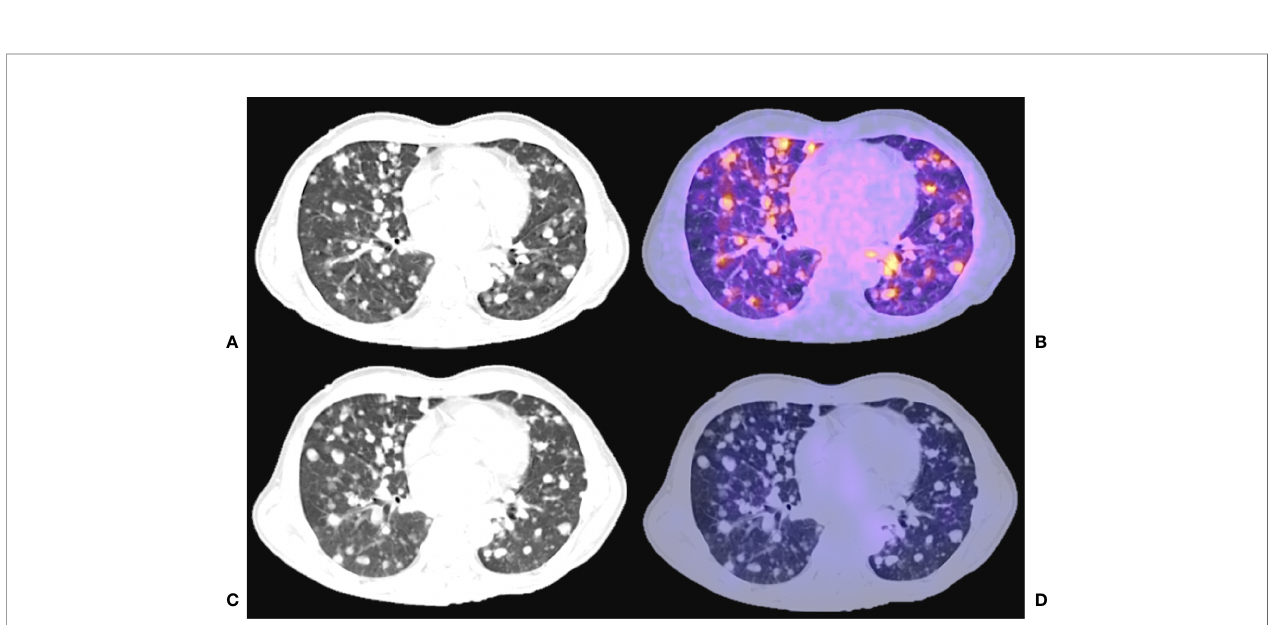
FIGURE 1 | 55 years old female, papillary thyroid carcinoma classic variant, treated with thyroidectomy + RAI (22200 MBq cumulative dose). Thyroglobulin 1384 ng/ ml. Fused hybrid and simple CT thoracic images. (A) CT acquired for PET fusion (B) 68 Ga - PSMA PET/CT. (C) CT acquired for SPECT fusion (D) 131 I